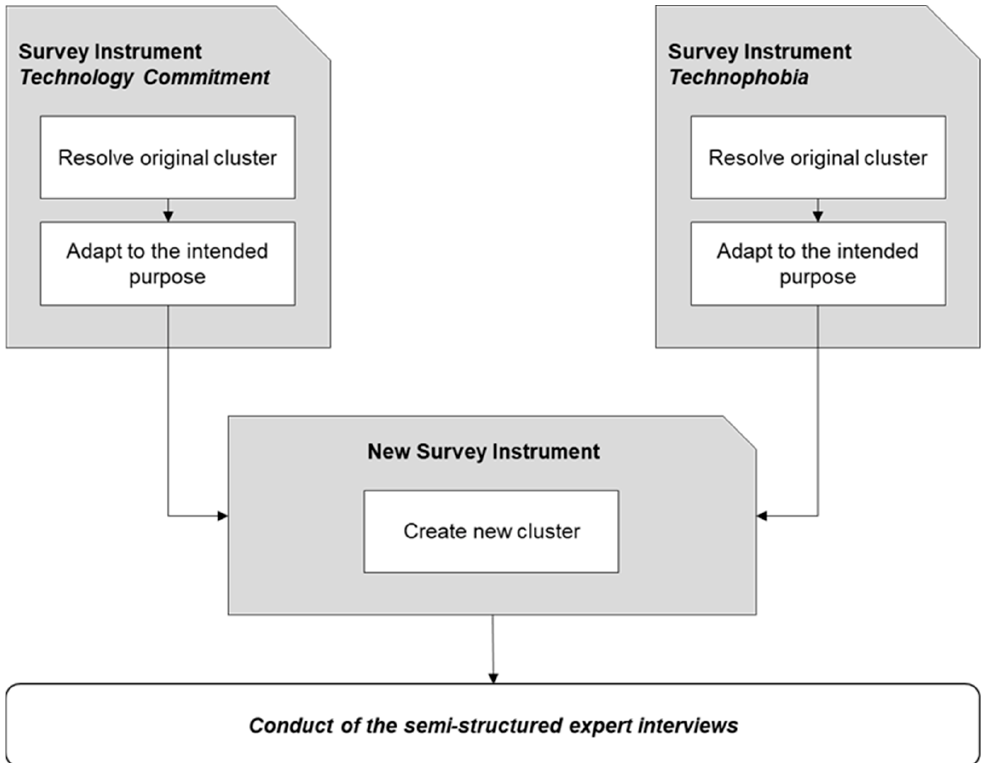
Figure 4. Adapting the two survey instruments Technology Commitment by Neyer et al. [63] and Technophobia by Sinkovics [64] for semi-structured expert interviews with construction companies.